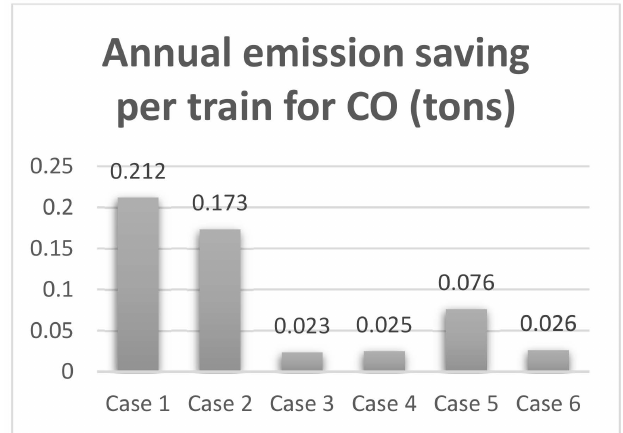
Figure 7. Comparison of annual emission saving per train for CO (tons) for the six cases when using the electric brake regenerative technique.